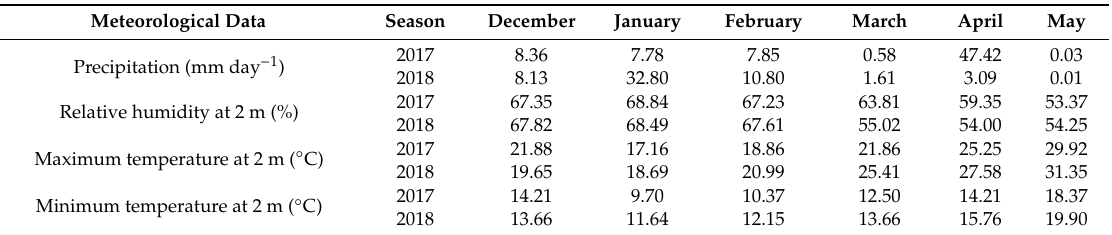
Table 1. The weather conditions of the experimental location during two growing seasons from sowing to harvesting